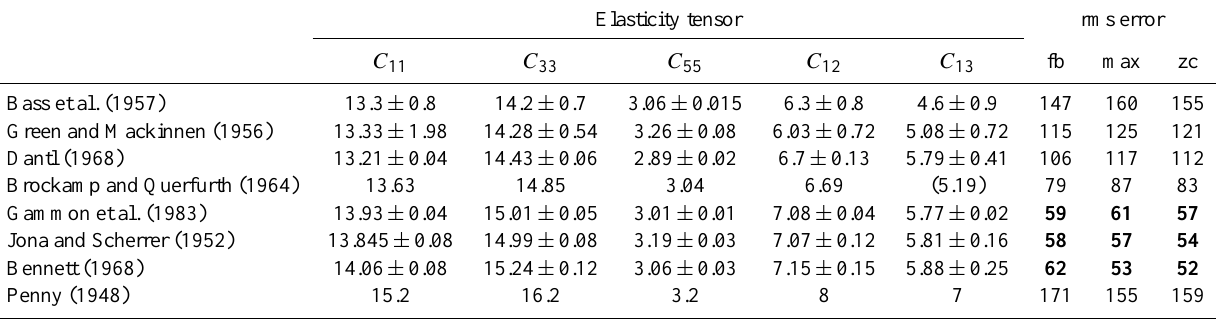
Table 1. Different measured elasticity tensors and the calculated elasticity tensor of Penny (1948) (all values in 10 9 Nm − 2 ). The order follows later calculations of the P-wave velocities from lower to higher velocities using the given elasticity values. The second part of the table gives the root-mean-square (rms) error in ms − 1 calculated from the VSP interval velocities derived from first break (fb), maximum (max) and zero-crossing (zc) picks in comparison to the EDML interval velocities derived from the COF eigenvalues. The smallest rms errors are in bold